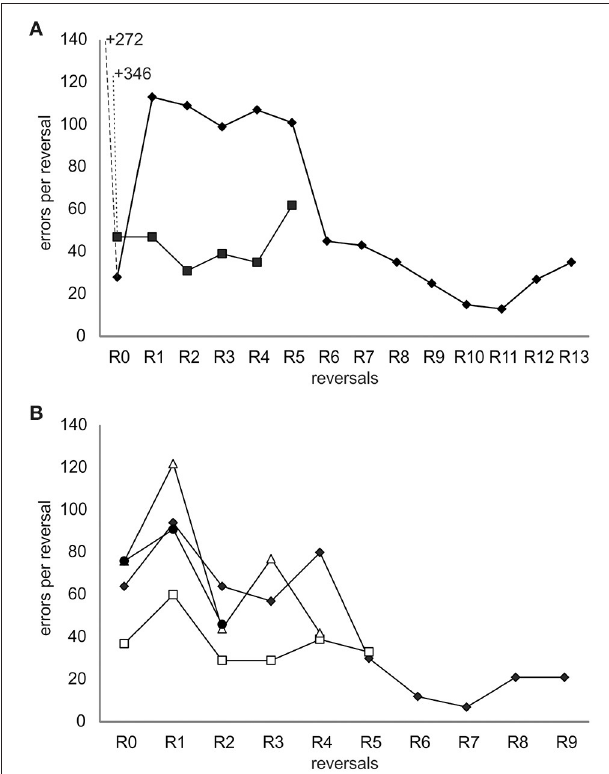
FIGURE 3 | Error curves of all individuals trained in the spatial reversal learning experiment. (A) Results from individuals from group 1 trained with the incorrect-choice-signal (ICS) at a later stage of training. The data points indicate the number of errors made until the learning criterion was met during a reversal including the errors made in the two sessions in which it achieved a performance at or exceeding 80% correct choices. The number of errors before ICS signaling was started is written as numbers in the graph allowing the same scaling of the y-axis of the two graphs and thus a direct and better comparison of the performance of groups 1 and 2. The data of Ov1 are marked with filled diamonds and that of Ov2 with filled squares. (B) Results from individuals of group 2 trained with the ICS from the beginning of the experiment. The data of Ov4 are marked with filled diamonds, that of Ov5 with open squares, that of Ov6 with open triangles, and that of Ov7 with filled circles. Irrespective of the group, all animals learned the original task and reversed multiple times completing 2–13 reversals, and their performance showed a general trend to improve over